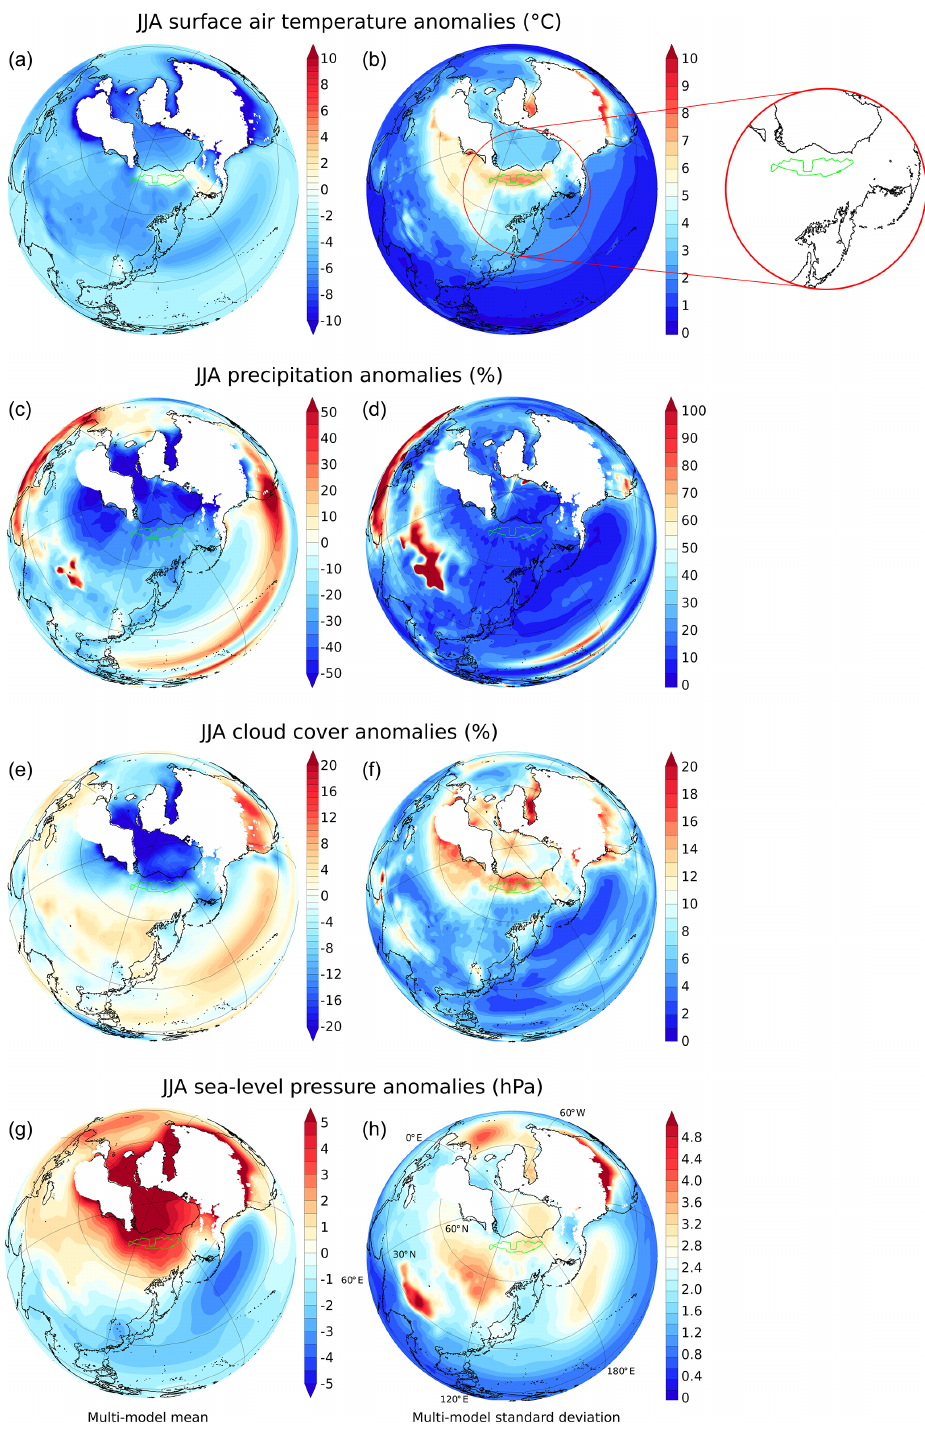
Figure 1. The PMIP2 and PMIP3 multi-model mean (left panels) and multi-model standard deviation (right panels) in LGM JJA climate anomalies. (a–b) Temperature anomalies ( ◦ C). (c–d) Precipitation anomalies (%). (e–f) Cloud cover anomalies (%); (g–h) sea-level pressure anomalies (hPa). All anomalies are calculated with respect to PI. Note that regions covered by continental ice sheets during the LGM have been masked out. The green contour (shown in magnification in the top right) shows the Siberian target region, defined here as the region in which the PMIP multi-model standard deviation is larger than 7 ◦ C. The LGM coastlines are given in